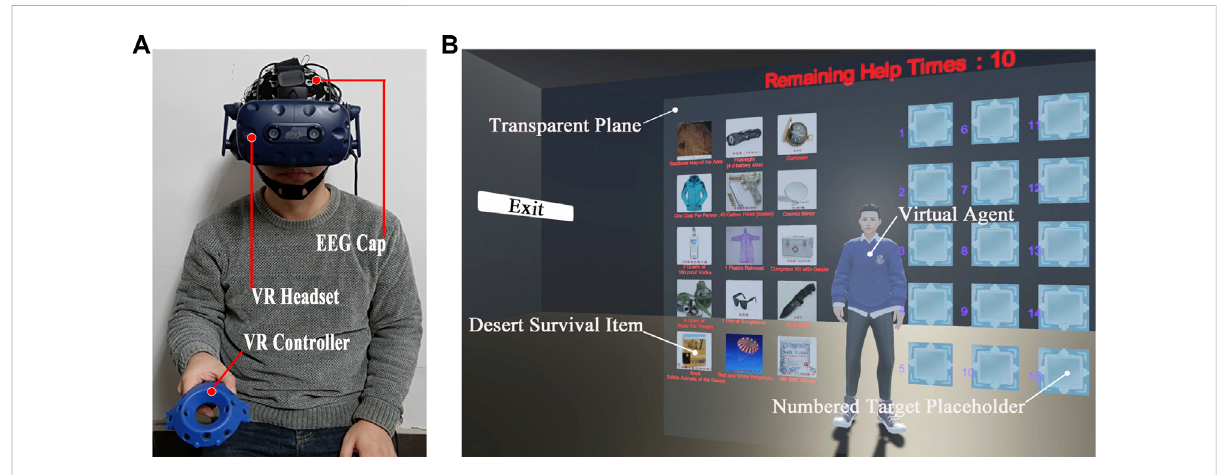
FIGURE 1 These two fi gures demostratetheVR setup and environment, (A) istheVR con fi guration with EEG sensor added, (B) istheVR environmentwith an embodied virtual